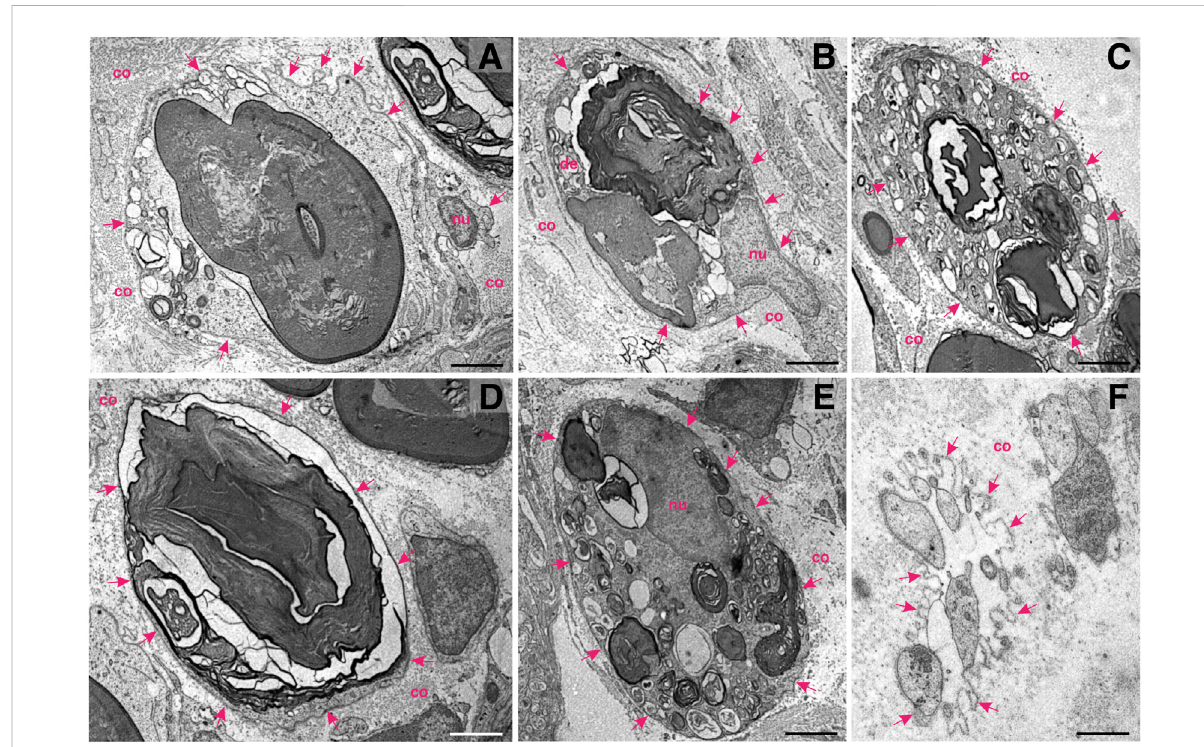
FIGURE 2 Schwann cells at work — ultrastructural patterns of myelin decomposition in the distal stump of a transected murine femoral nerve. (A) A degenerating axon amidst compacted myelin within the Schwann cell cytoplasm. Multiple proteolytic vesicles are visible in the cytoplasmic rim. A basal lamina (arrows) and collagen (co) isolate the Schwann cell from the extracellular matrix. (B) Ovoid fi gures of partially degraded myelin and peripheral vesicular fusion at multiple sites. The nucleus (nu) of the Schwann cell is visible. (C) A multitude of cytoplasmic vesicles and a few compartments of degraded myelin. The basal lamina (arrows) is an important border, which isolates the dynamic cell interior from the surrounding. (D) Decomposition of a huge mass of myelin within a myelinating Schwann cell. (E) Portioning and proteolytic degradation of myelin